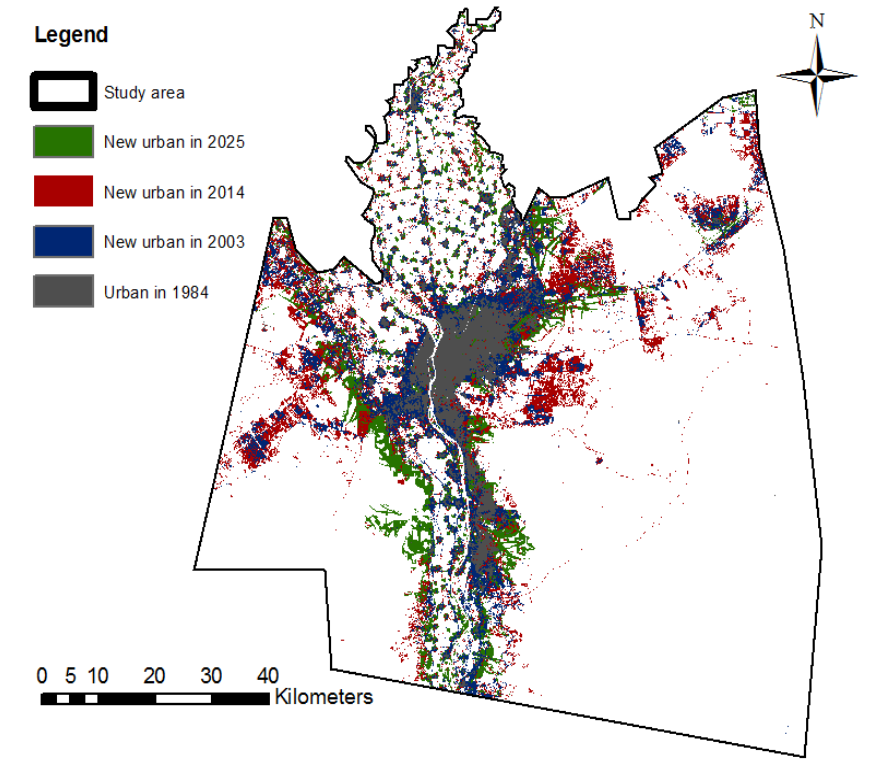
Figure 7. Urban growth in the GCR.